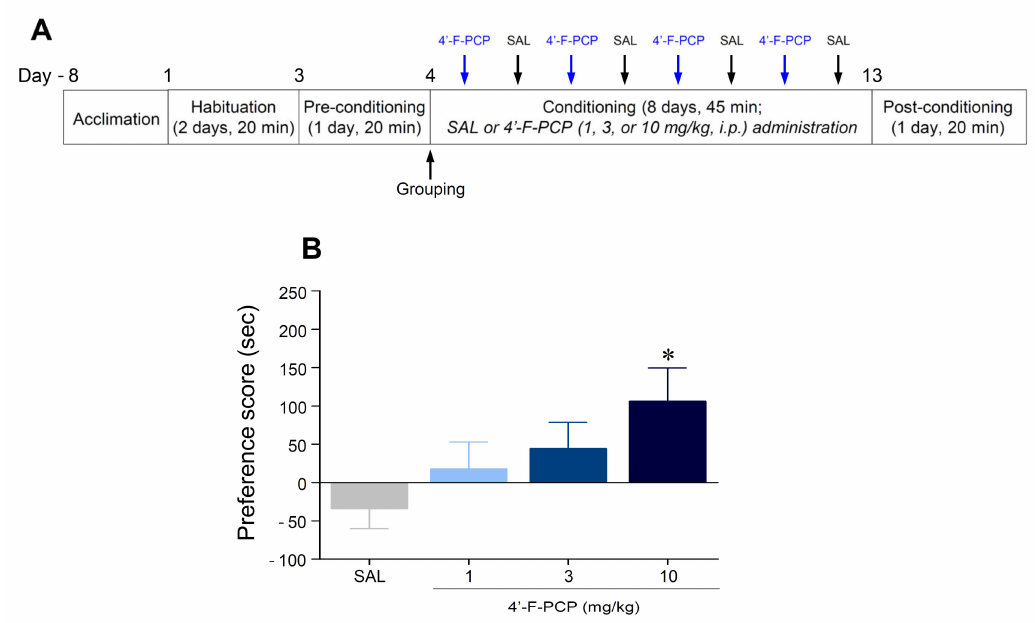
Figure 2. E ff ect of 4 (cid:48) -F-PCP on conditioned place preference (CPP) in mice. ( A ) Experimental timeline for CPP test of 4 (cid:48) -F-PCP. ( B ) E ff ect of 4 (cid:48) -F-PCP (1, 3, or 10 mg / kg, i.p.) on place preference. Asterisk * indicates p < 0.05 vs. saline-conditioned group. SAL: saline. n = 12 per